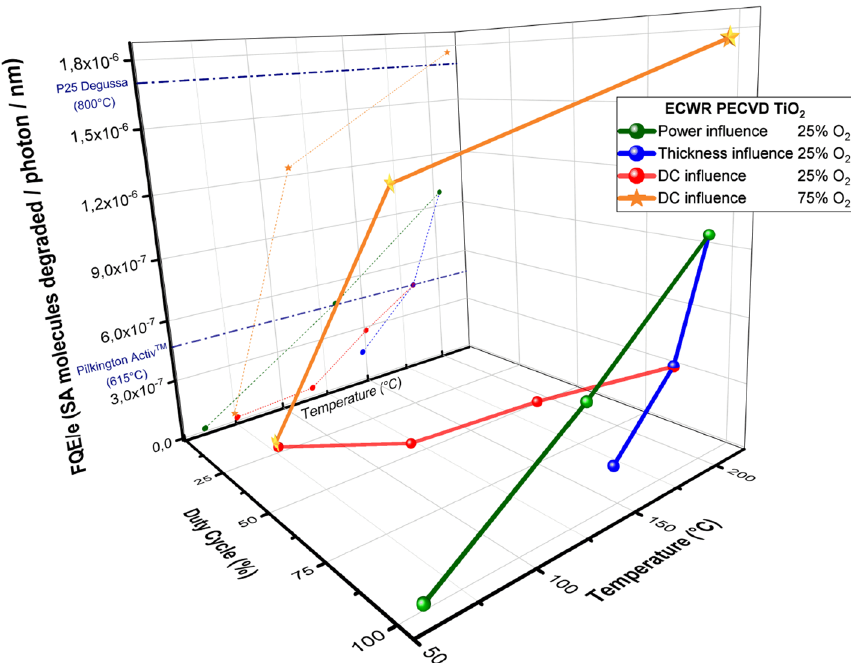
Figure 7. Summary of Normalized Photocatalytic Efficiency (SA molecules/photon 365 nm/coating thickness) for all samples obtained during the optimization study and values of references in the field 23